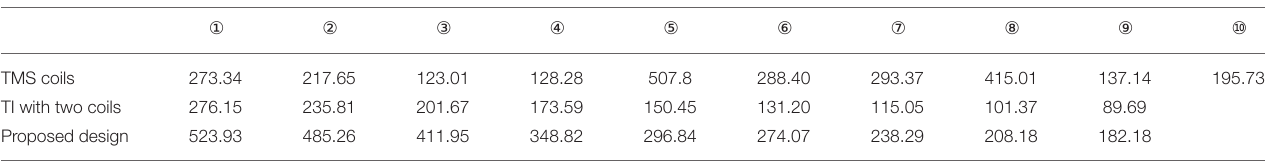
TABLE 1 | Maximum electric field intensity of different coil design